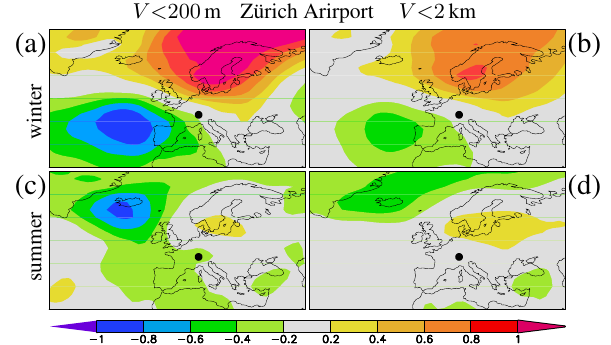
Fig. 9. As Fig. 8 but for Z¨urich Airport.